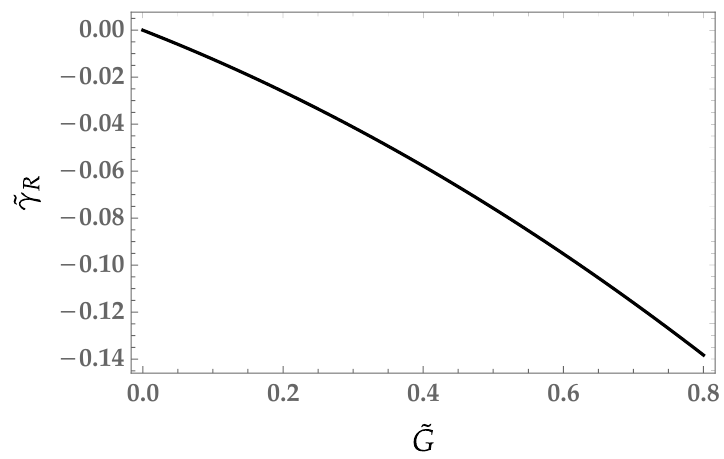
Figure 3. The gamma function ˜ γ R in the order ∂ 4